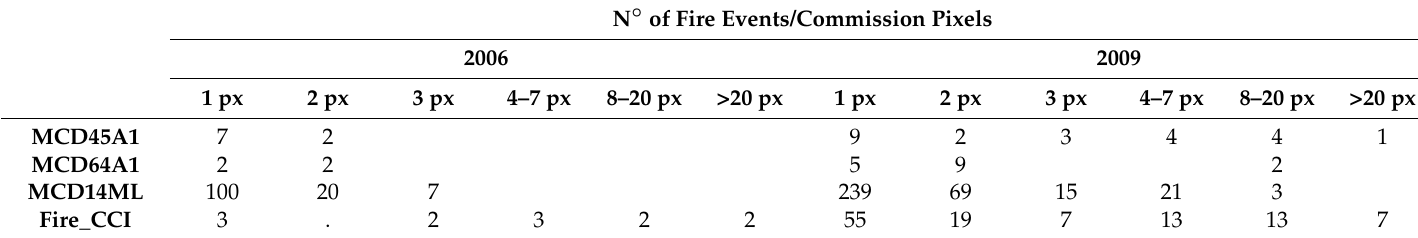
Table 4. Number of committed fire events organized by their size in pixels. Pixel sizes is relative to individual fire